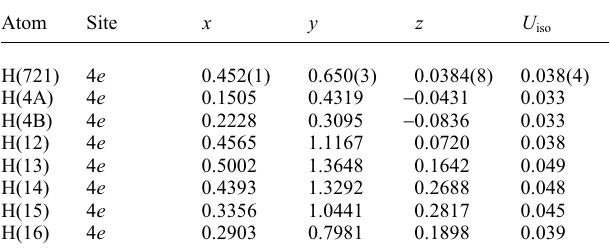
Table 2. Atomic coordinates and displacement parameters (in Å 2 )